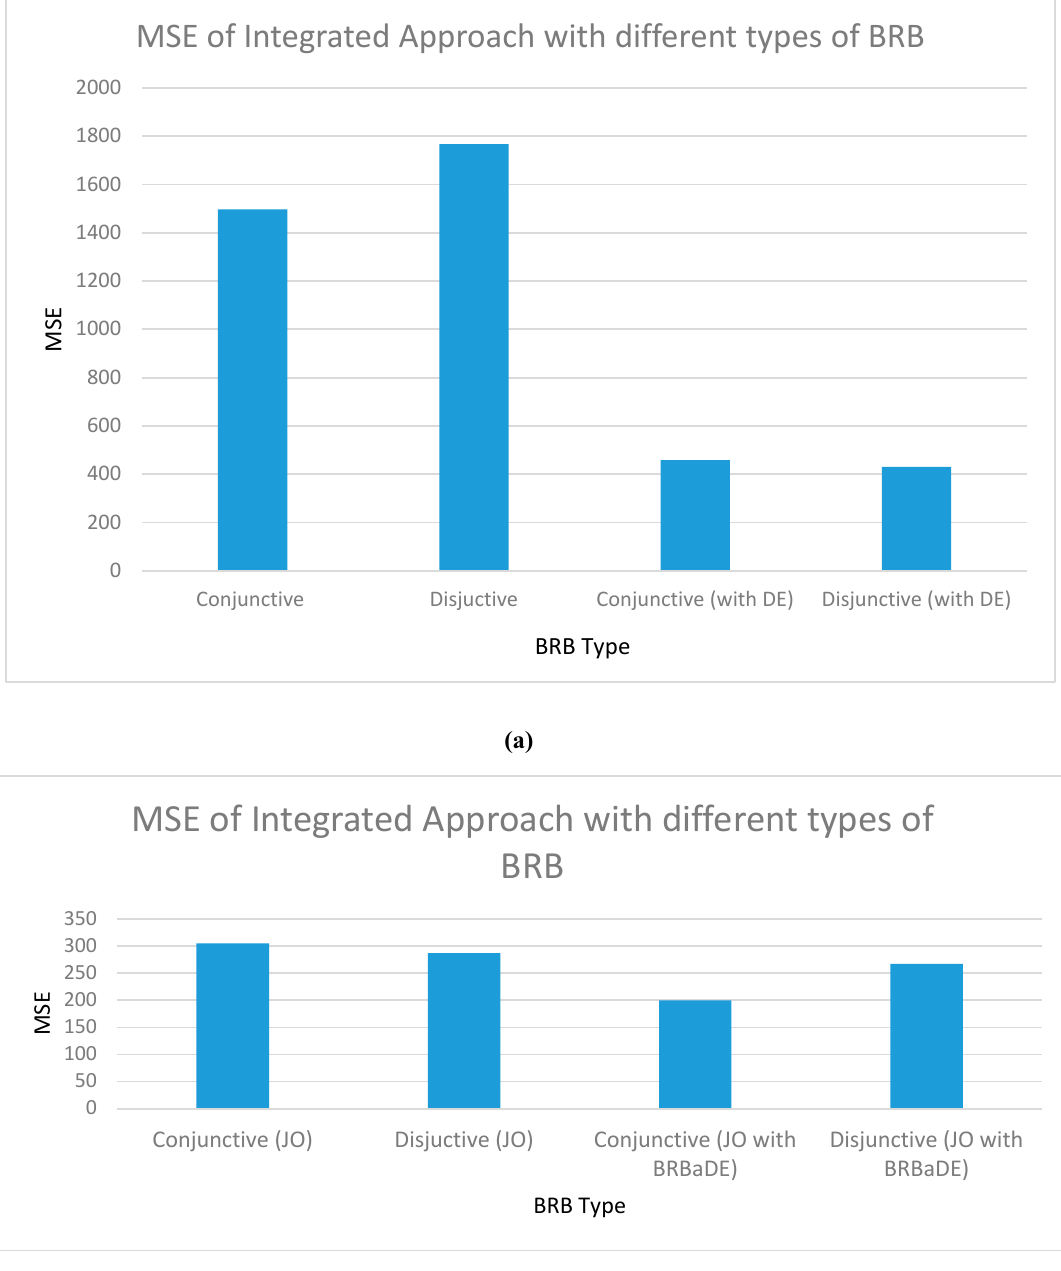
Figure 7. Testing dataset Mean Square Error (MSE) of our integrated approach with Conjunctive and Disjunctive BRB: ( a ) non-trained and DE-optimized; ( b ) Joint Optimized (JO), including BRB adaptive DE (BRBaDE).